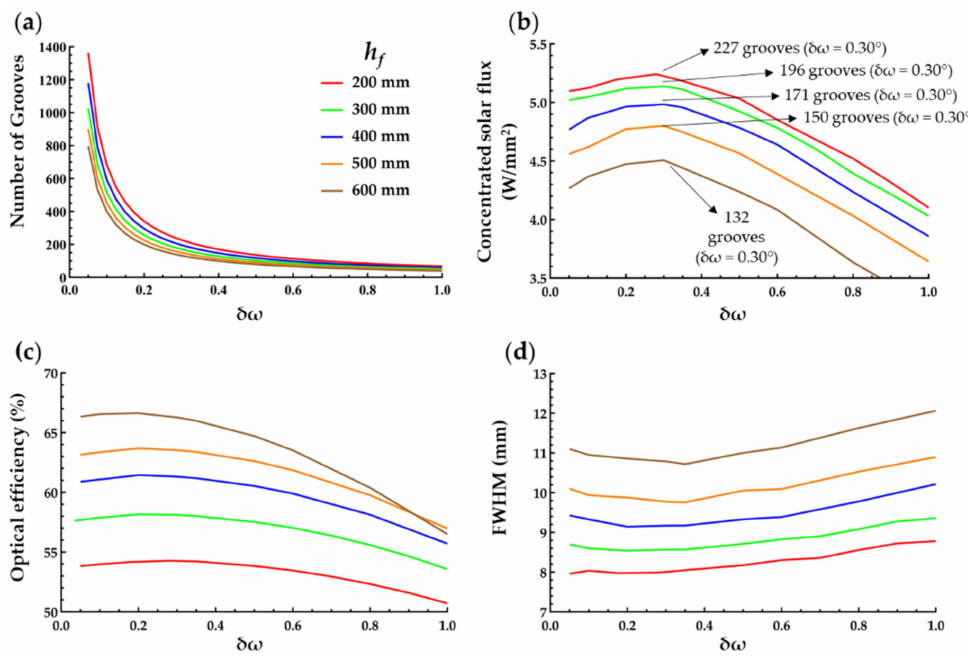
Figure 15. Characteristics of the Gaussian distribution source at the focal zone: ( a ) number of grooves per δω , ( b ) concentrated solar flux, ( c ) optical efficiency and ( d )